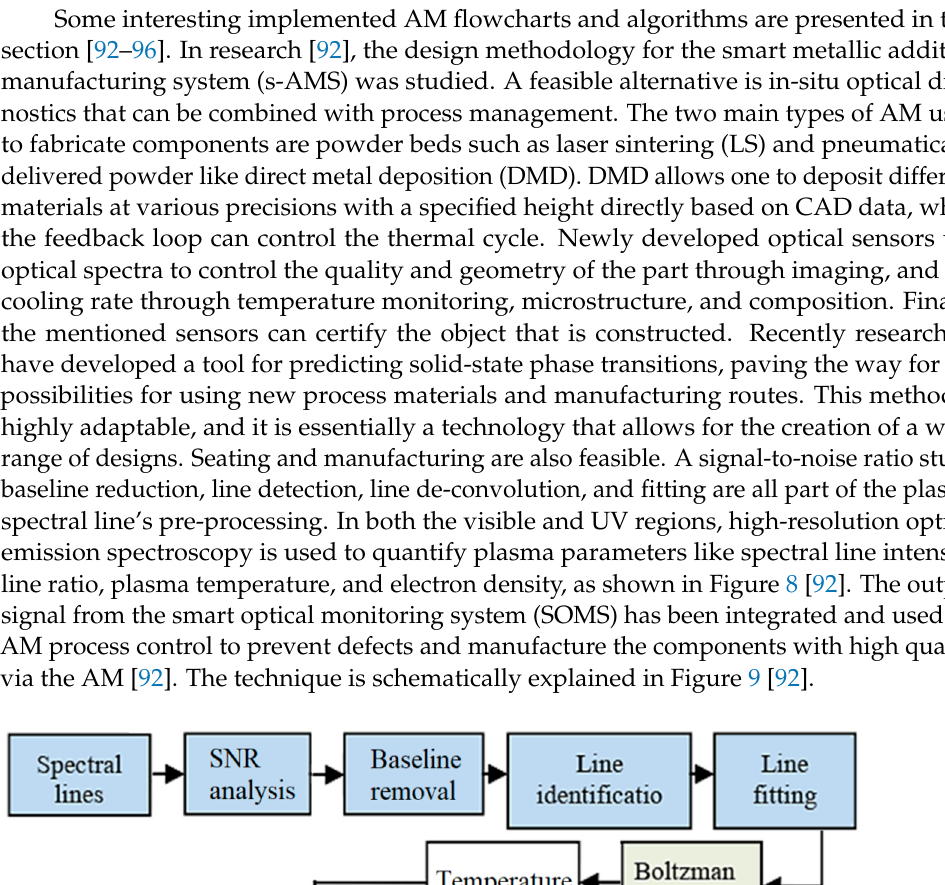
Figure 9. Flowchart for SOMS-based closed-loop control for AM [92].